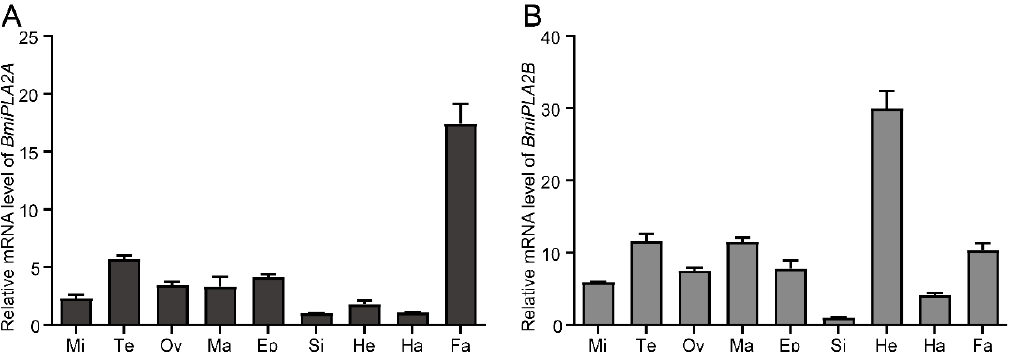
Figure 4. Tissue distribution of BmiPLA2A ( A ) and BmiPLA2B ( B ). Si: silk gland, Ma: Malpighian